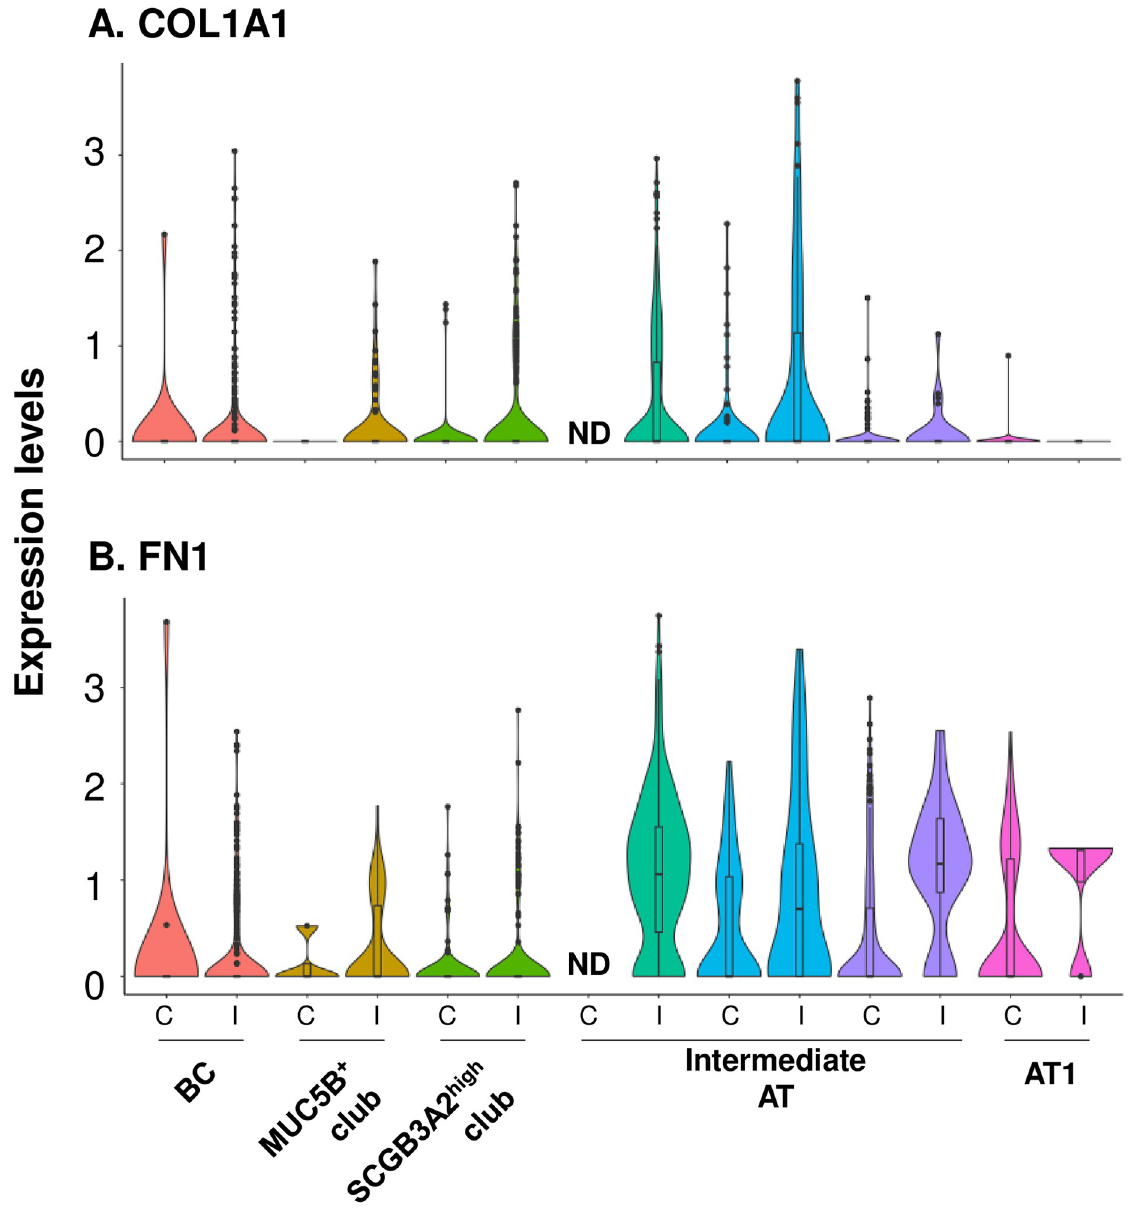
Fig 5. Expression of extracellular matrix genes in SCGB3A2 + alveolar cells in populations of lung epithelial cells. Violin plots showing the expression of extracellular matrix genes SCGB1A1 (top) , SCGB3A2 (middle) , and IPF genetic risk factor gene MUC5B (bottom) in the cell populations from control (C) and IPF (I) donors identified in Fig 2A. A . SCGB1A1. B. FN1. Note that sub-cluster 4 was not detected (ND) in control cell